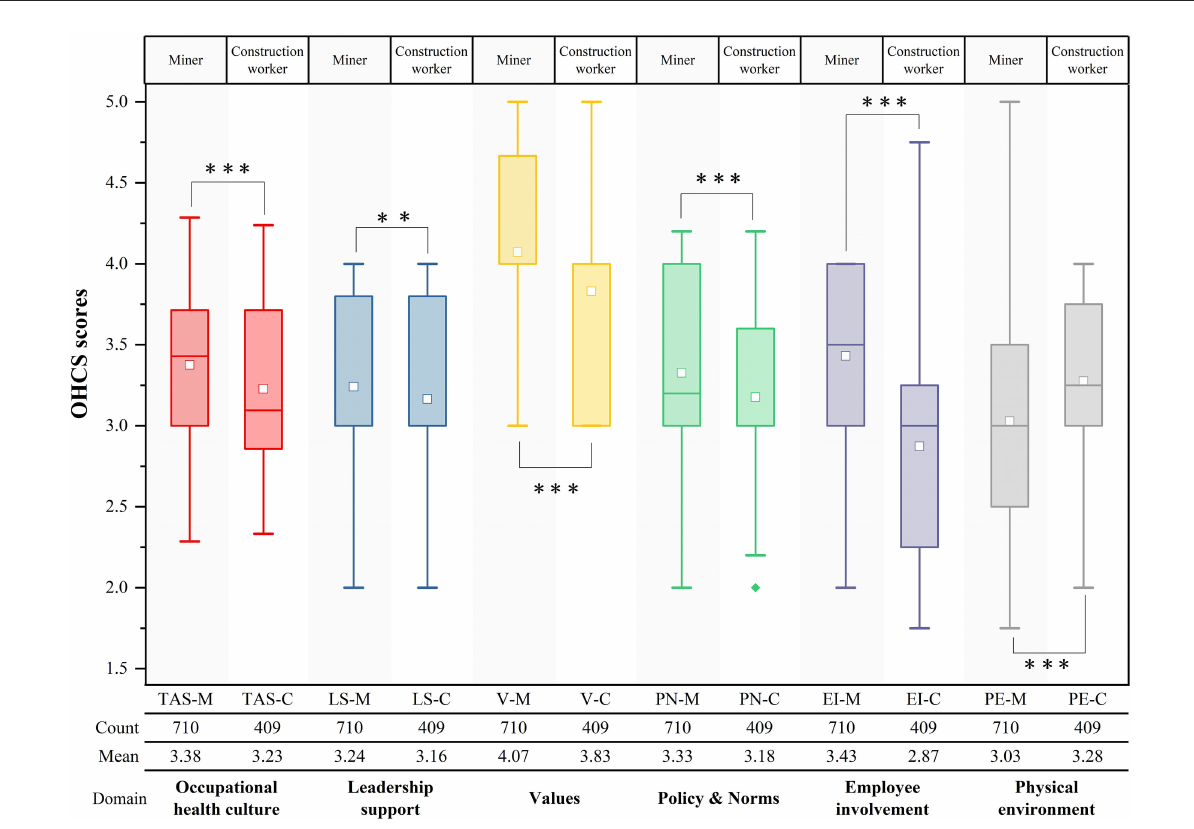
FIGURE4 Analysis of the difference in OHCS scores between miners and construction workers. TAS-M, total average occupational health scale scores of miners; TAS-C, total average occupational health scale scores of construction workers. *** P < 0.001, ** P <